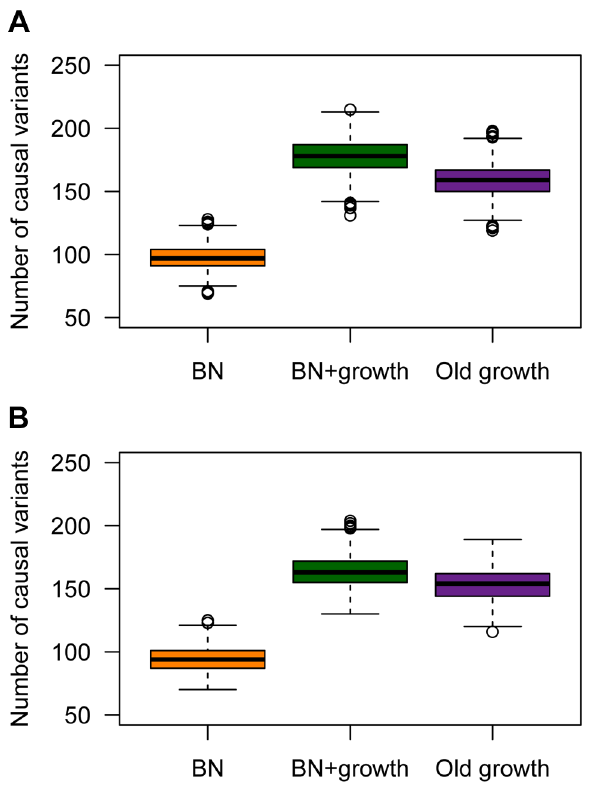
Figure 5. The number of causal variants in a sample of 1000 cases from each simulated population. ( A ) A SNP’s effect on the trait is correlated with its effect on fitness ( t =0.5). Note that the population that experienced recent growth (green; BN + growth) has a higher number of causal variants than the population that did not recently expand (orange; BN). ( B ) A SNP’s effect on the trait is ~ 0 : 05 and independent of its effect on fitness ( t =0). Here h 2 C M =70